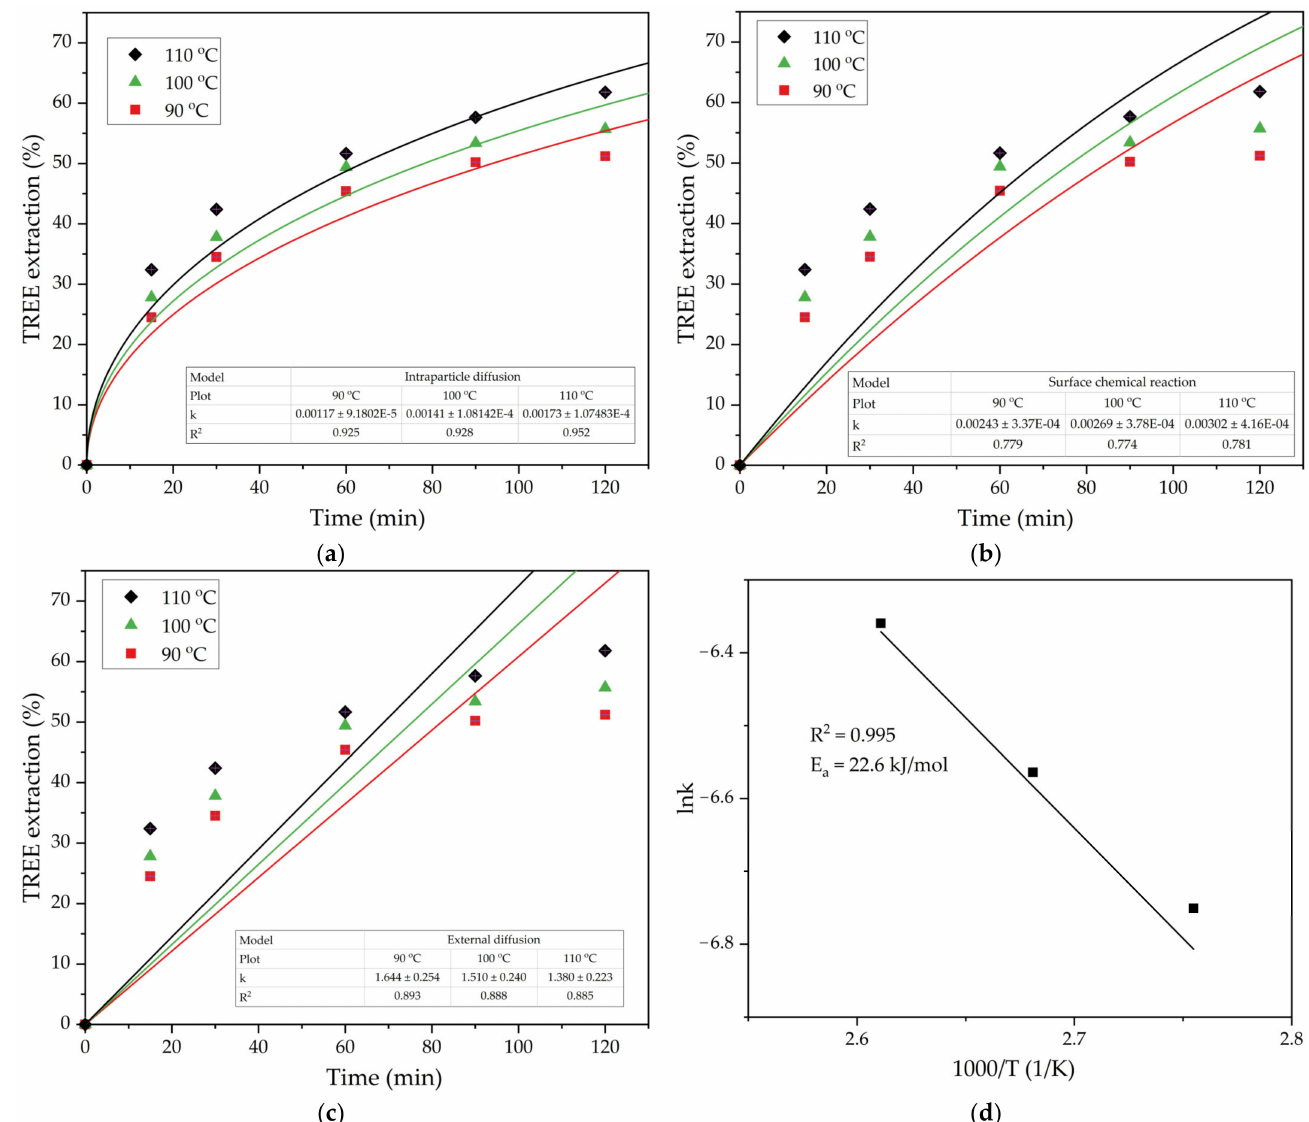
Figure 9. Results of fitting the experimental data (T = 90–110 ◦ C, L/S ratio = 10) using the SCM model for the process limited by the diffusion through the solid product ( a ) by the surface chemical reaction ( b ) and by the diffusion through the liquid film ( c ) and the plot showing the dependence of lnk for the diffusion through the solid product on the inverse temperature (Arrhenius plot) ( d